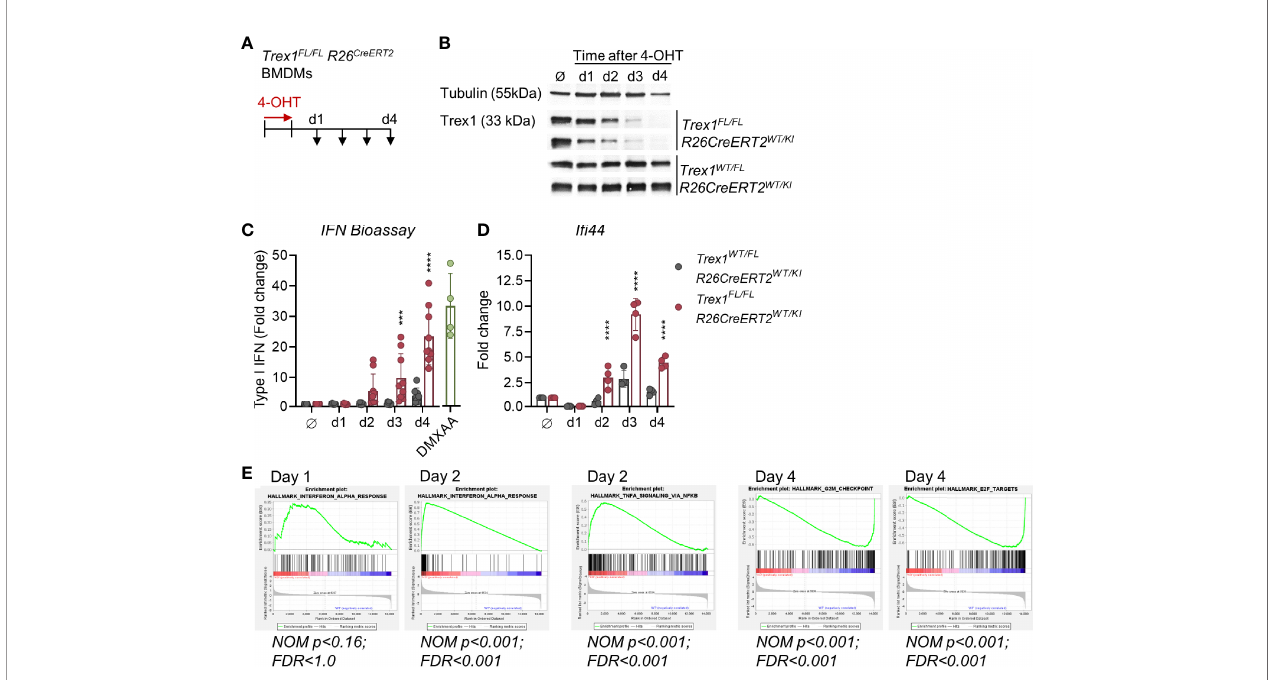
FIGURE 5 | Rapid loss of TREX1 and onset of type I IFN responses upon induced inactivation of Trex1 in vitro . (A) Inactivation of the Trex1 gene was induced in macrophages differentiated from Trex1 FL/FL R26 CreERT2 bone marrow (BMDMs) by culture in the presence of 4-OHT for 1 day. 4-OHT treated BMDMs from Trex1 WT/FL R26 CreERT2 mice as well as non-4-OHT-treated cells from both genotypes were used as controls. Samples were obtained on days 1-4 after end of 4- OHT induction. (B) Western blot analysis of TREX1 expression in BMDMs at the indicated time points after 4-OHT induction, representative of 6 animals per genotype. (C) Assay for type I IFN bioactivity in supernatant of BMDMs sampled at the indicated time points after 4-OHT induction. Supernatant was added to 1x10 4 LL171 luciferase IFN-reporter cells followed by quanti fi cation of luciferase activity ( Trex1 FL/FL R26 CreERT2 n = 9, control n = 8). Supernatant of WT BMDMs treated with DMXAA served as high control. (D) Transcript levels of the ISG I fi 44 determined by qRT-PCR in BMDMs sampled at the indicated time points after 4-OHT induction. Fold change compared to untreated control cells (n = 4) is shown. (E) Gene set enrichment analysis of RNA sequencing data from Trex1 FL/FL R26 CreERT2 vs. control ( Trex1 WT/FL R26 CreERT2 ) BMDMs sampled at the indicated time points after 4-OHT induction. ****p < 0.0001, ***p <